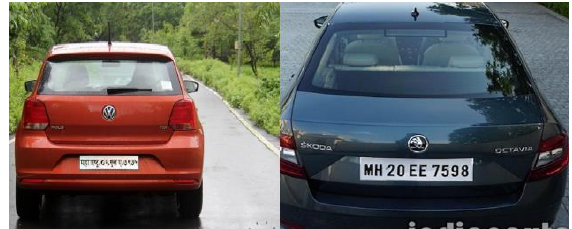
Fig. 2. Image Acquisition of the vehicle